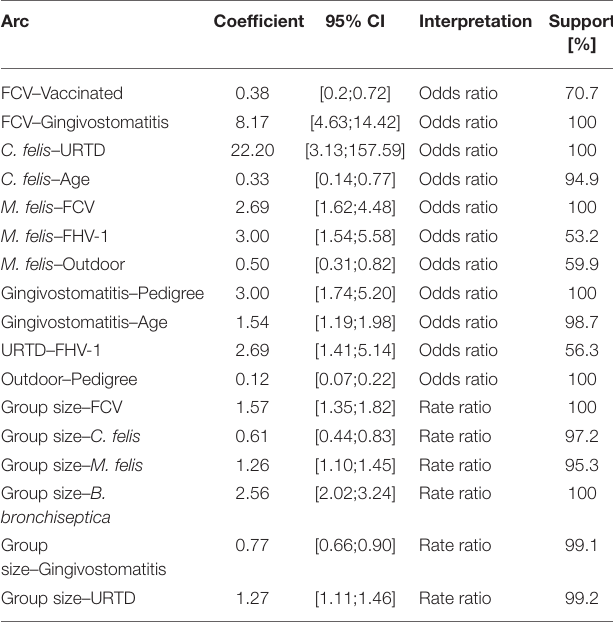
TABLE 2 | Regression coefficient estimates and 95 % Confidence Intervals (CI) with their interpretation and data support (computed with structural